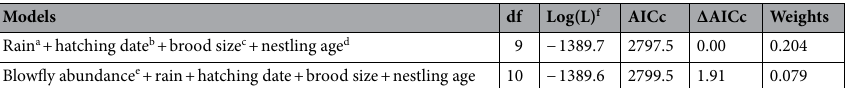
Table 3. Selection of linear mixed effect models (ΔAICc < 2) best explaining variation in the length of the 3rd primary feather (mm) of Wood Warbler nestlings (response variable; n = 129 nests). The remaining covariates also included in the global model, but dropped during model selection, were: the average mean daily ambient temperature (°C) in the period when nestlings were > 4 days old until their measurement (at median 8 days old), ant presence (as a factor), habitat type (deciduous or mixed deciduous-coniferous) and study year (as a factor). A null model had only a fixed intercept, and a random effect was the individual nest. a The total sum of rainfall (mm) in the nestling stage when nestlings were > 4 days old until their measurement; b relative hatching date of Wood Warbler nestlings (days from the median hatching date in a year); c the number of nestlings hatched; d the number of days since hatching (day 0; set as a factor); e the number of blowfly larvae or pupae per nestling in nests with and without blowflies; f log- likelihood.